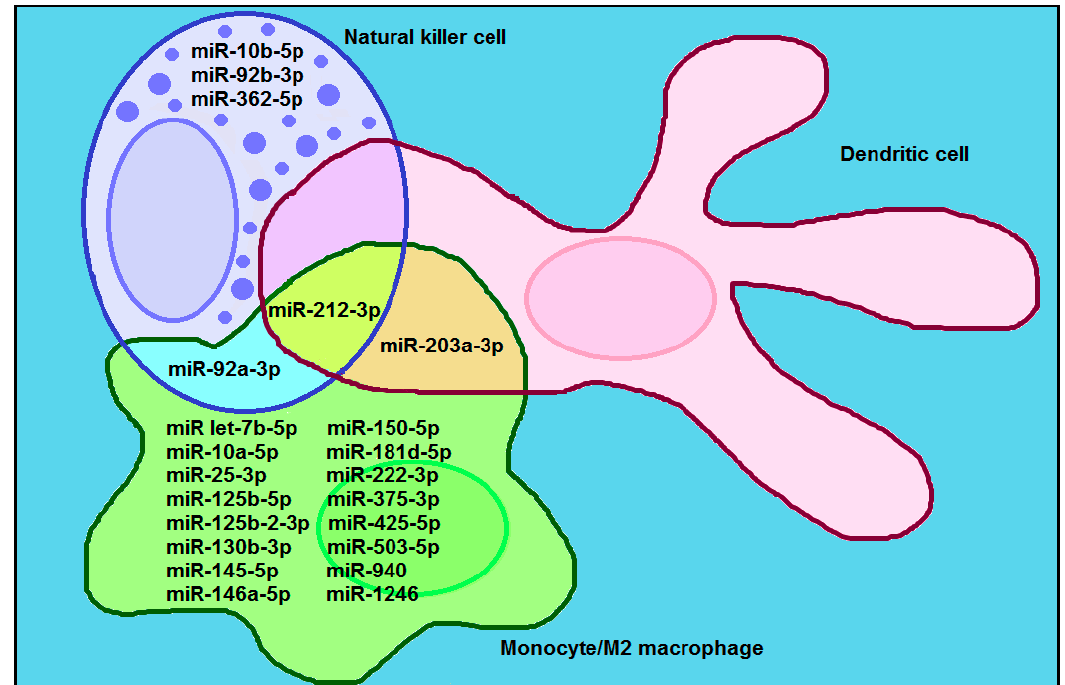
Figure 5. Venn diagram displaying the overlap of 17 exosomal pro-tumoral miRNAs transferred from cancer cell to macrophages, natural killer cells and dendritic cells. cancer cell to macrophages, natural killer cells and dendritic cells.